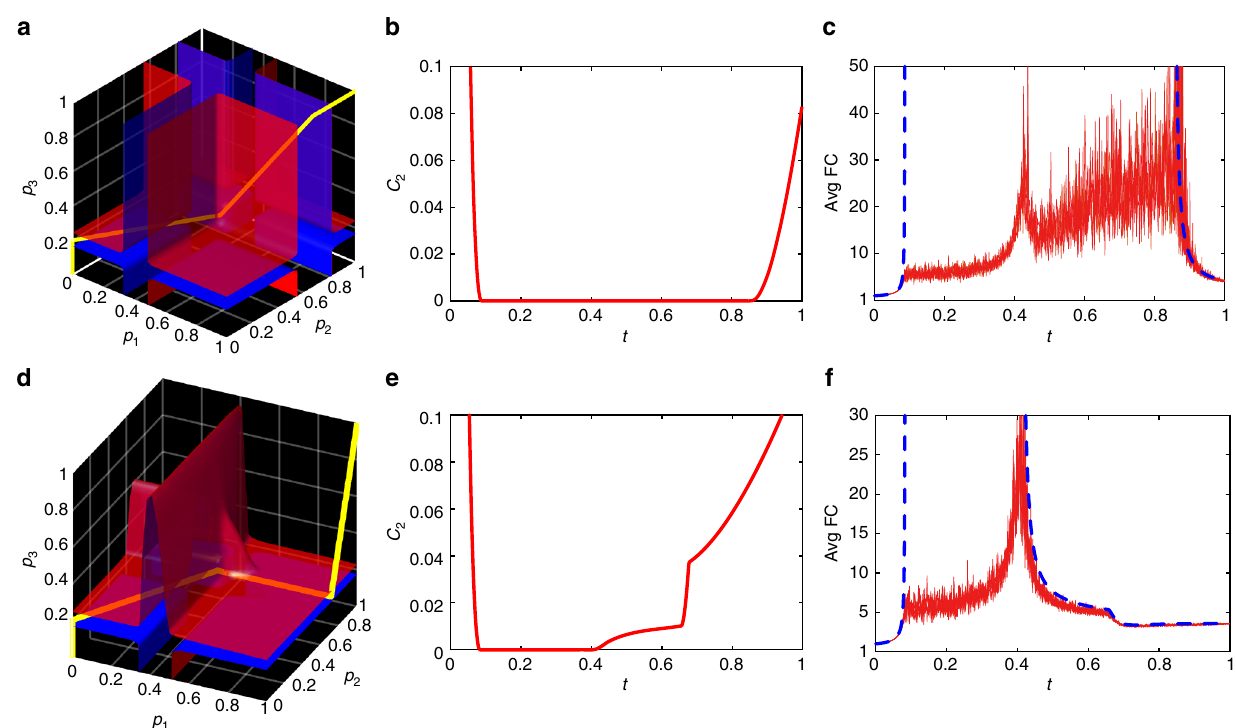
= 0.02). b , e The C fi les corresponding to the 2 2 -pro